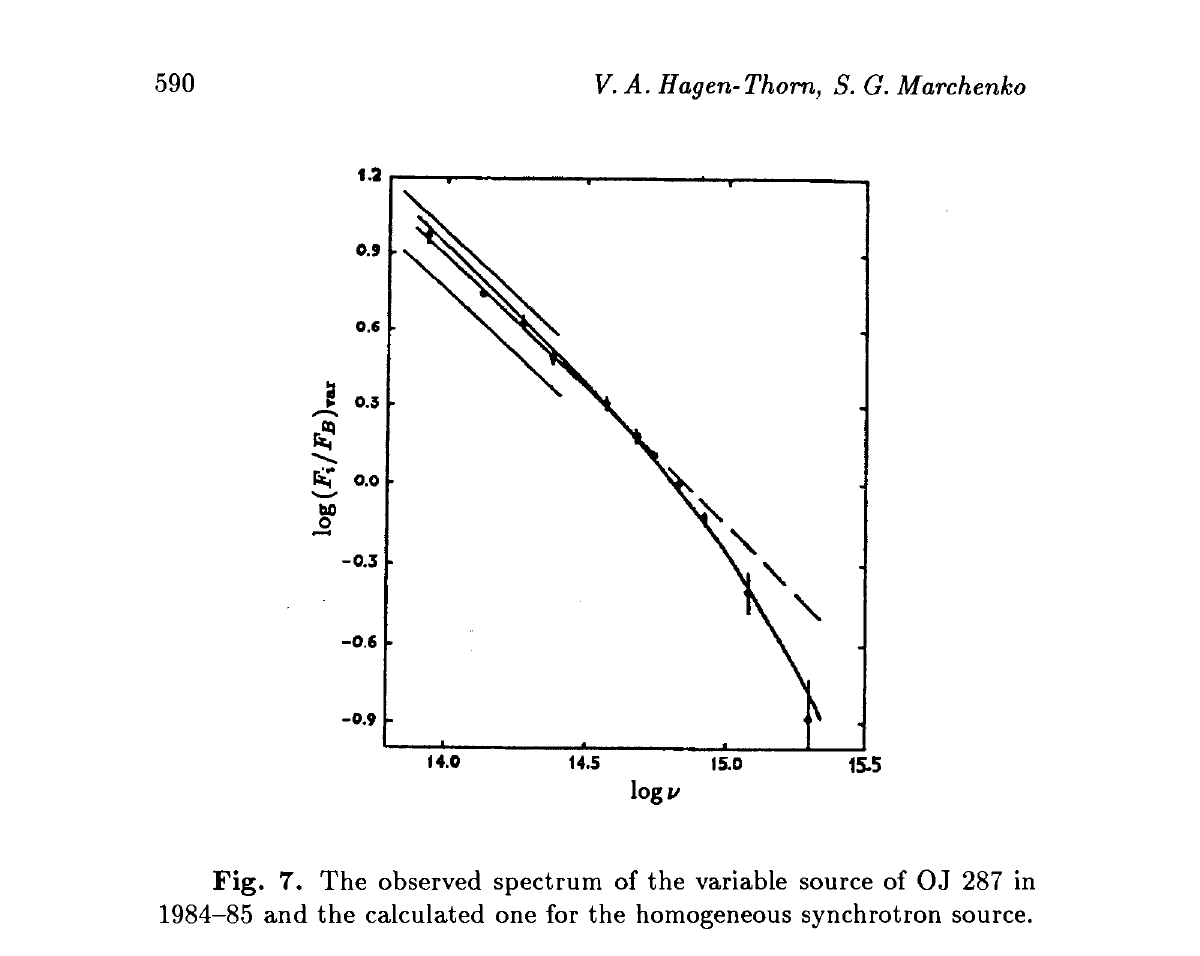
Table 1. The sources of polarized radiation.